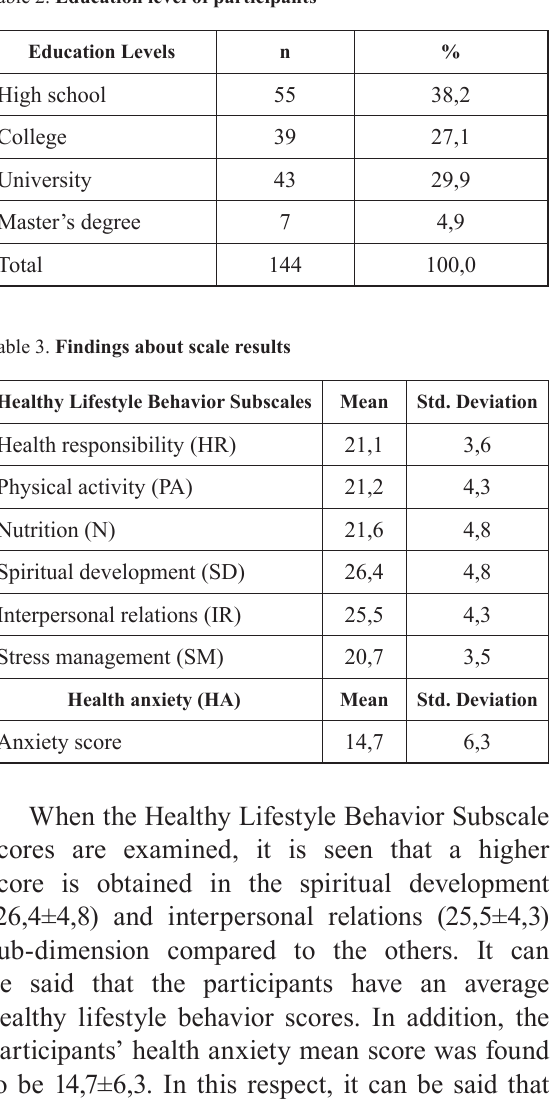
Table 2. Education level of participants